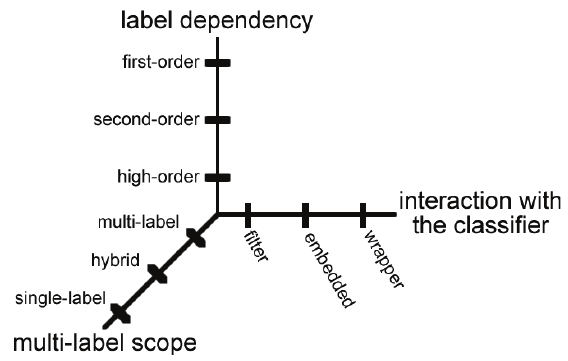
Figure 1: A taxonomy to organize publications on multi-label feature selection It is believed that identifying label dependency may contribute to improve learning